Question: Name the type of graph shown.
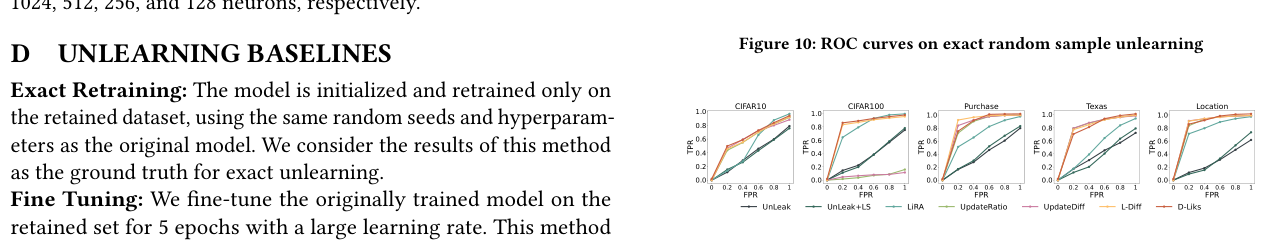
Answer: line